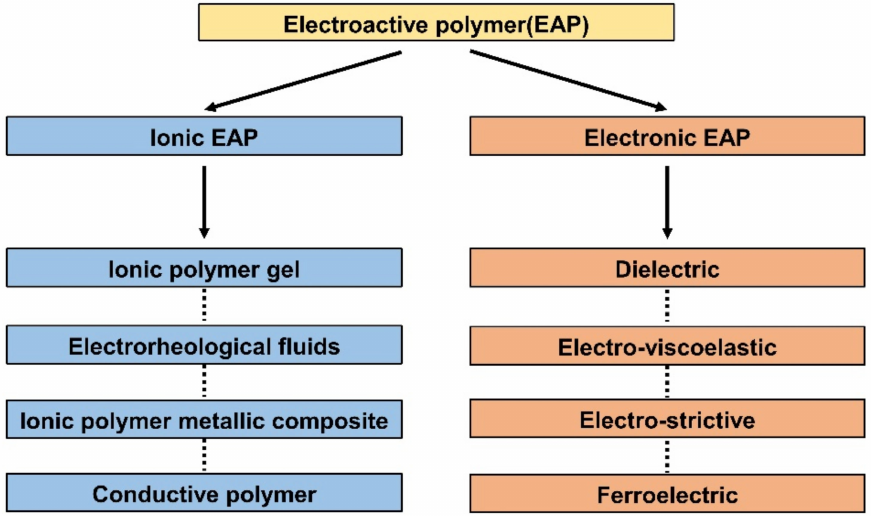
Figure 1. Classification of various electroactive polymers. Adapted from Rahman et al. [16] with permission from MDPI, Copyright